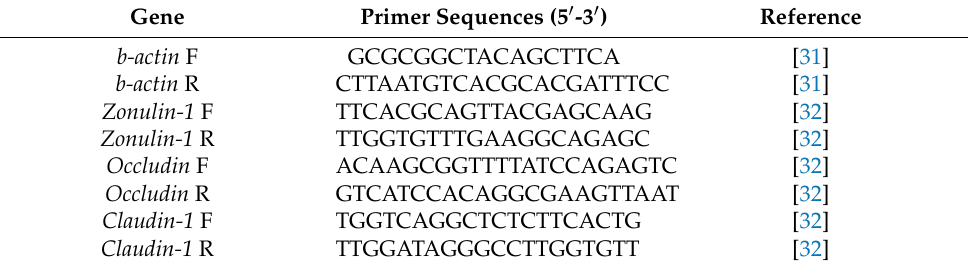
Table 2. Sequences of primers used for quantitative real-time PCR. Gene Primer Sequences (5 (cid:48) -3 (cid:48)